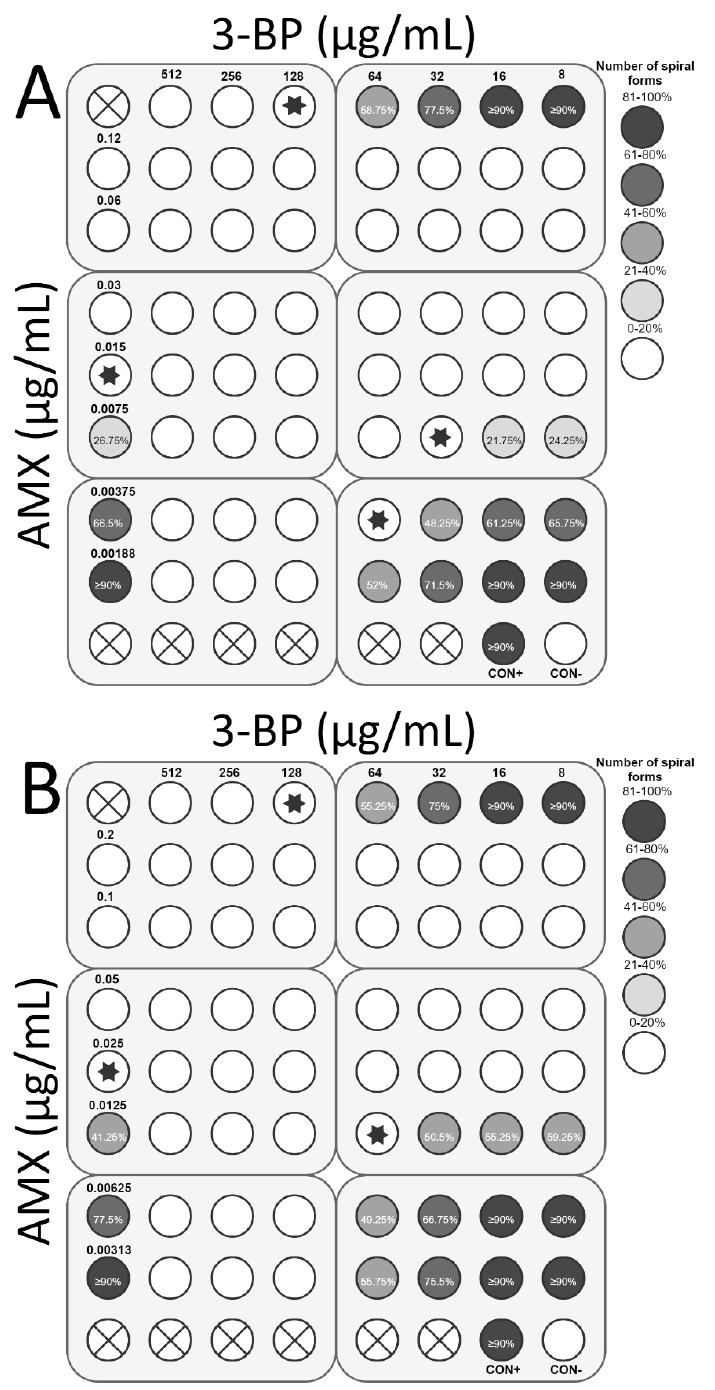
Figure 10. The antibacterial and morphological effects of 3-Bromopyruvate (3-BP), amoxicillin (AMX), and combinations of both against H. pylori Tx30a and 7143 strains. The existence of the interaction in the antimicrobial activity of 3-BP with AMX was determined against ( A ) the reference antibiotic-susceptible H. pylori Tx30a and ( B ) the clinical double-resistant H. pylori 7143 strain. The white circles indicate the wells in which the number of spiral forms was ≤ 15%, while the white circles with a cross in the middle indicate empty wells. Using asterisks, the wells with the MICs of the tested substances were marked, whereas in the case of the interaction verifications, they indicate the lowest FIC. Abbreviations: 3-BP, 3-Bromopyruvate; AMX, Amoxicillin; CON+, Positive control; and CON − , Negative control.